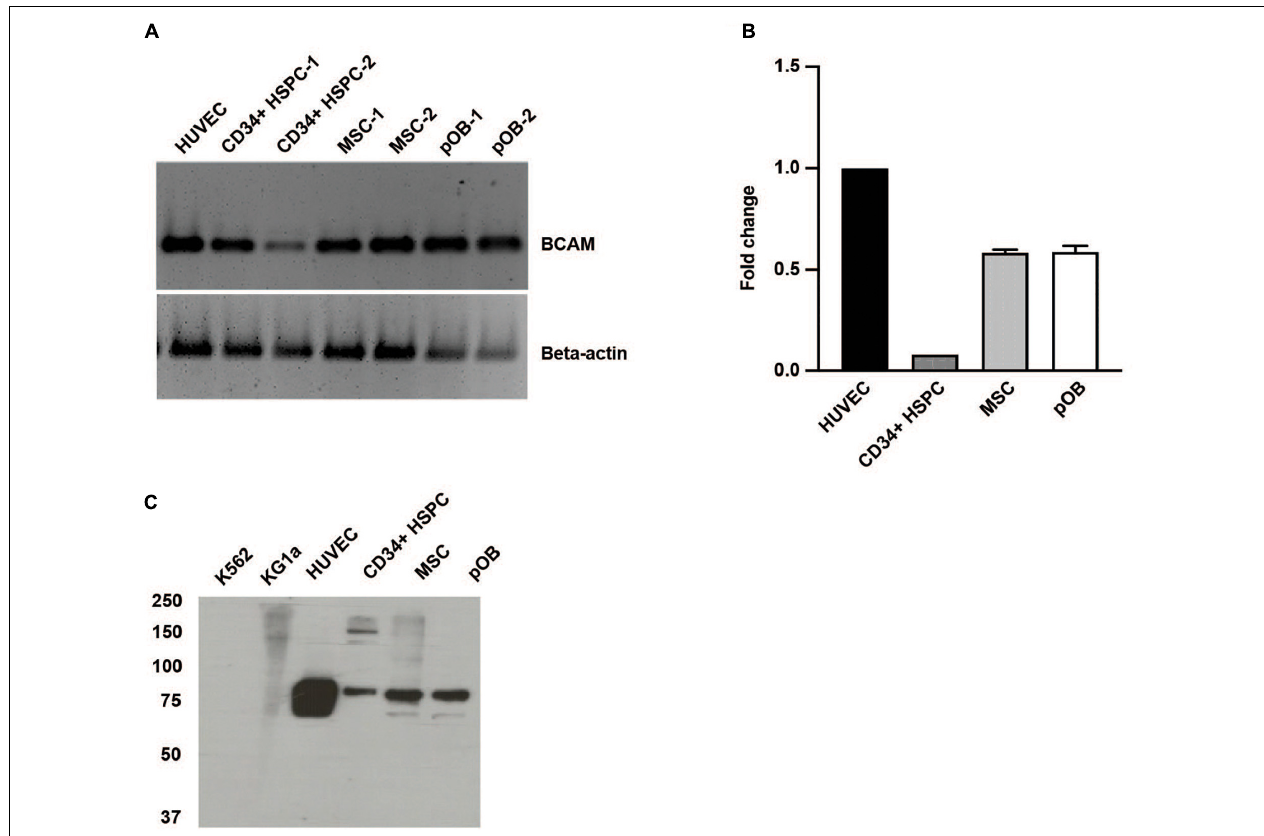
FIGURE 1 | Human HSPC and bone marrow niche cells express BCAM/Lu. (A) RT-PCR analysis of CD34 + HSPC, human umbilical vein endothelial cells (HUVEC), bone marrow mesenchymal stromal cells (MSC), and primary osteoblasts (pOB) showing the expression of human BCAM/Lu on all cell types. (B) qRT-PCR analysis showing the quantification of expression of BCAM/Lu, and the fold change in expression relative to HUVEC was determined. (C) Immunoblotting using a monoclonal antibody against the extracellular domain of BCAM/Lu revealed the expression of BCAM/Lu on HUVEC, CD34 + HSPC, MSC, and pOB, but not on K562 or KG1a